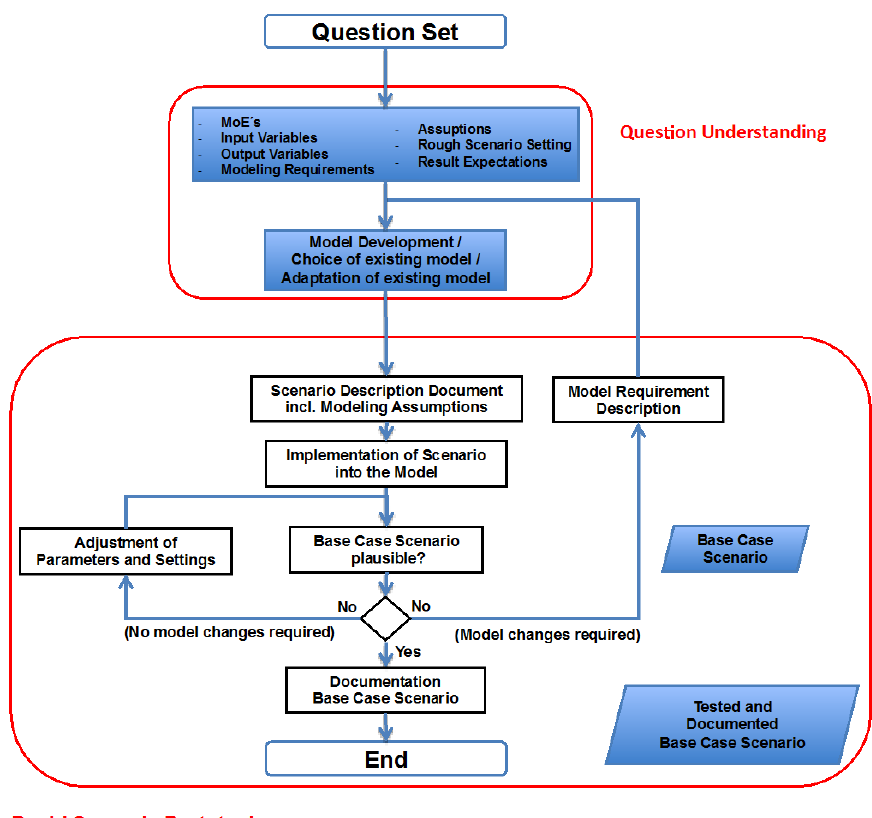
Figure 3. Rapid scenario prototyping process [1].